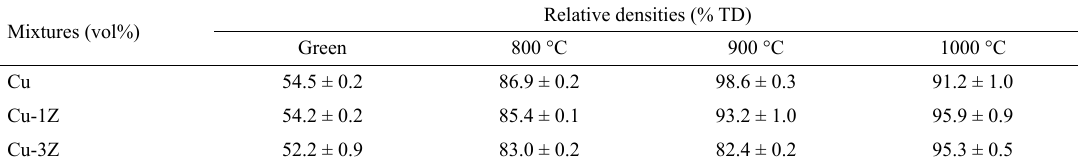
Table 2. Relative densities of green and sintered tapes of Cu, Cu-1Z and Cu-3Z. Mixtures (vol%)